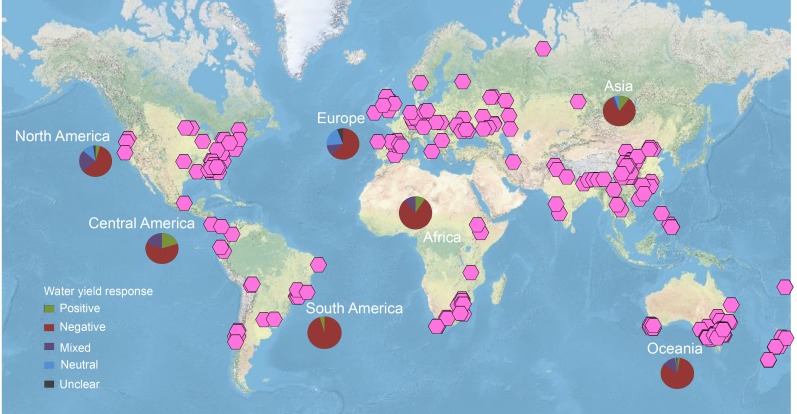
Geographic location of study cases and their water yield outcomes.Global distribution of study cases providing data on changes in water yield following forest restoration or forest cover expansion. The pie charts indicate the distribution of water yield responses reported in the studies from the different regions. Red represents a negative response, green a positive response, and purple mixed results. Neutral response is represented by light blue. Source for the world map is the US National Park Service (Natural Earth physical map; https://www.arcgis.com/home/item.html?id=c4ec722a1cd34cf0a23904aadf8923a0).